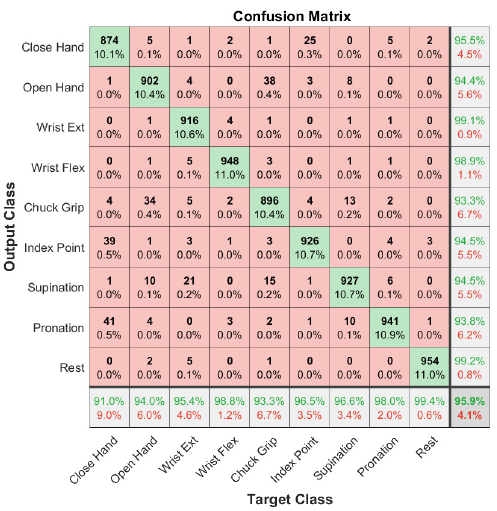
Figure 5. Confusion matrix for 10-fold cross-validation of a model trained on combined fabric data from three subjects. The bottom row is the recall, the right column is the precision, and the bottom right is the overall accuracy. Table 3. The mean and standard deviation of throughput (TP) for each experimental subject and overall during the usability test.